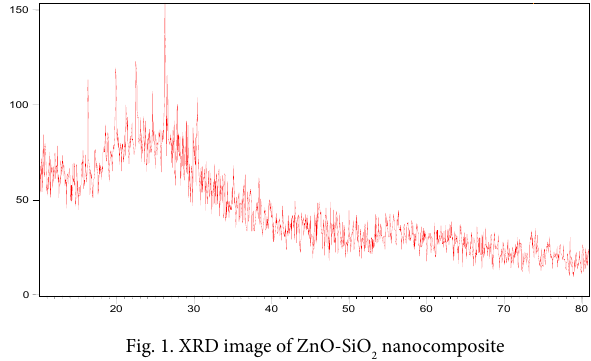
nanocomposite 2